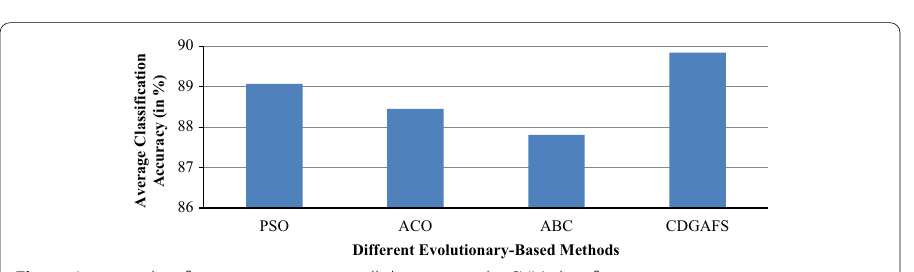
Fig. 4 Average classification accuracy over all datasets on the SVM classifier